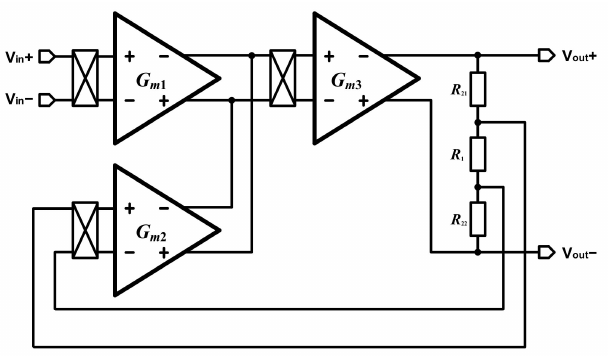
Figure 1. Conventional CFIA structure with a